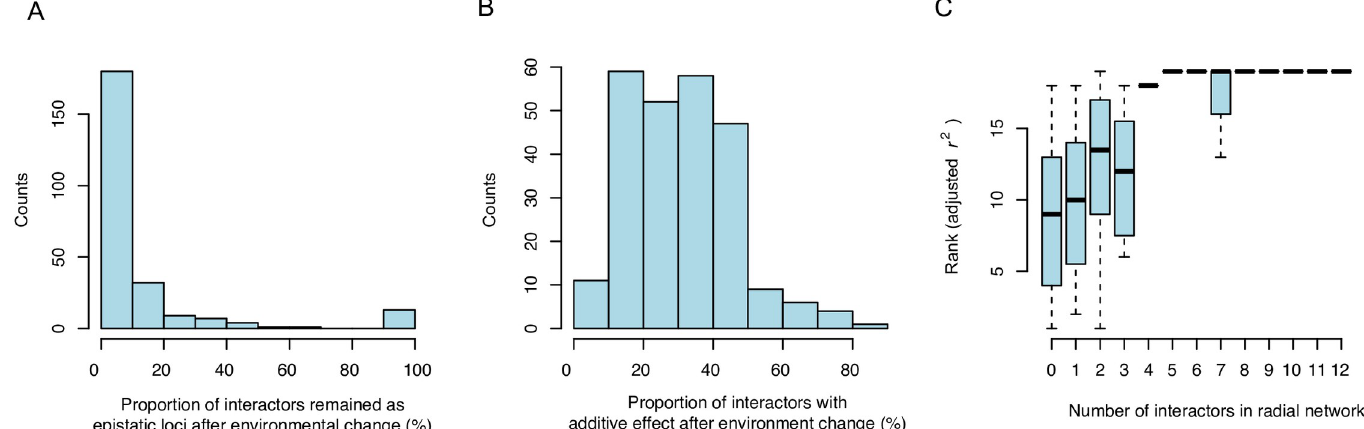
Fig 4. Illustrations of the dynamics of the interactions in the largest mapped epistatic networks, and their contribution to growth variation, across all tested environments. A) Histogram illustrating the changes in activity of network interactions in 13 epistatic networks, with more than 4 interactors, across the 20 environments. For each network, a set of interactors was defined to include the radial loci in the most highly activated environment. The percentage of these interactors that were epistatically active with the hub in each of the remaining 19 environments was calculated (x-axis). The overlap of interactors in the 13 networks across the 20 environments was summarized as the counts of environments with similar percentages of shared active interactors (y-axis). B) Histogram illustrating the percentage of interactors (defined as in A above) that have significant additive effects across the 13 networks and 20 environments. The x-axis shows the percentage of these interactors that have additive effects across the other 19 environments. The y-axis summarizes these percentages across the 13 networks. C) In each environment, adjusted r 2 values are calculated for all networks and ranks of these model fits were assigned. The association between the connectivity of the epistatic networks (x-axis; number of loci connected to the hub), and their contributions to the variance in growth (y-axis; rank of adjusted r 2 values) across the 13 networks and 20 environments, is illustrated as box-plots of these ranks grouped by the number of interactors.